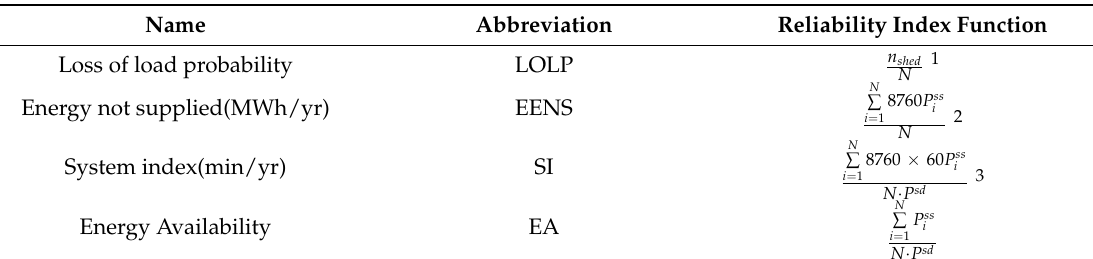
Table 1. Reliability indices of HVDC